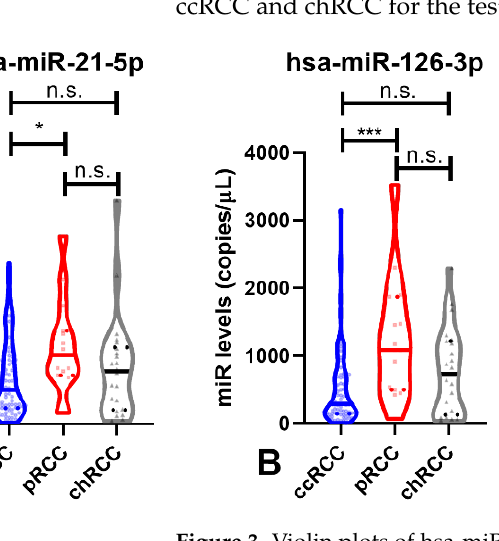
Figure 3. Violin plots of hsa-miR-21-5p ( A ), hsa-miR-126-3p ( B ), hsa-miR-155-5p ( C ) and hsa-miR- 200b-3p ( D ) levels in the malignant subtypes (ccRCC, pRCC and chRCC). Dashed lines indicate the interquartile range and horizontal line the median of miR levels. Abbreviations: ccRCC — Clear-Cell Renal Cell Carcinoma; chRCC — Chromophobe Renal Cell Carcinoma; pRCC — Papillary Renal Cell Carcinoma; n.s. — not significant, * — p -value < 0.05, ** — p -value < 0.001, *** — p -value < 0.0001.